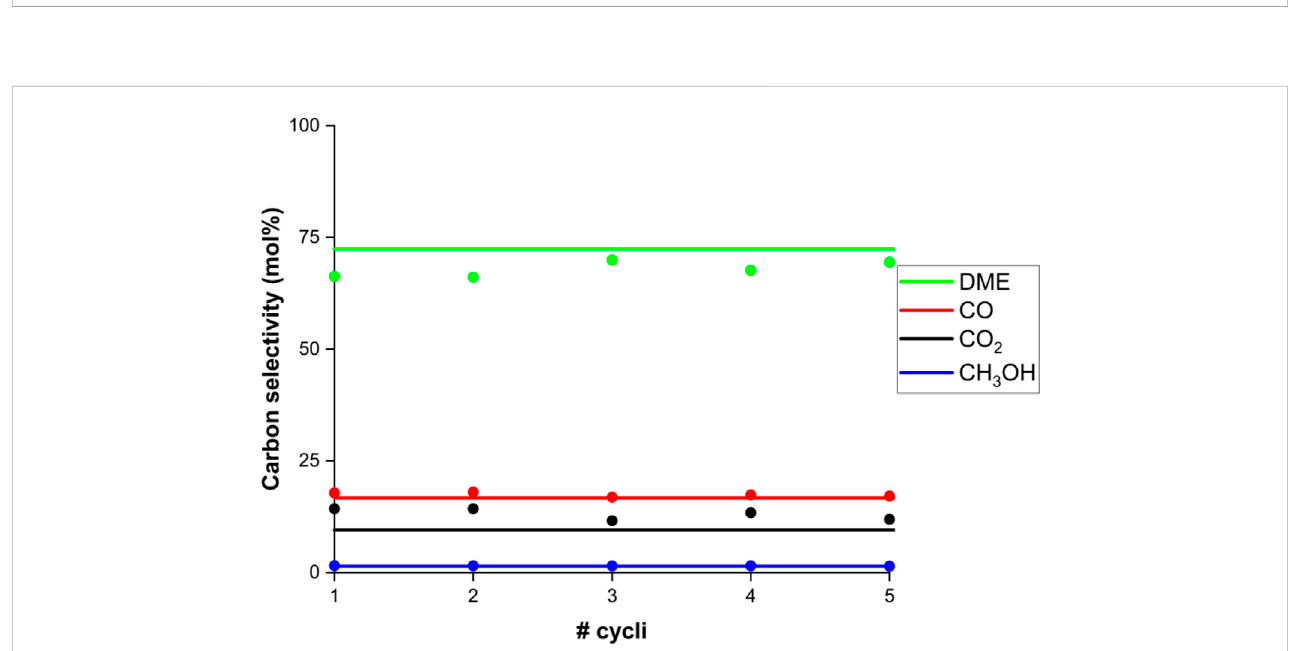
Experimental carbon selectivity (dots) to DME (green), CO (red), CO 2 (black) and methanol (blue) as function of the number of subsequent cycles. Model prediction for cyclic steady-state (lines). Conditions: 250 ° C and 25 bar(a) for a CO 2 feed with stoichiometric hydrogen, with argon